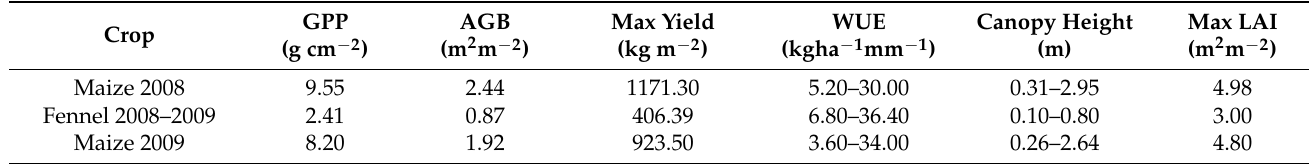
Table 4. Yield and crop productivity of maize and